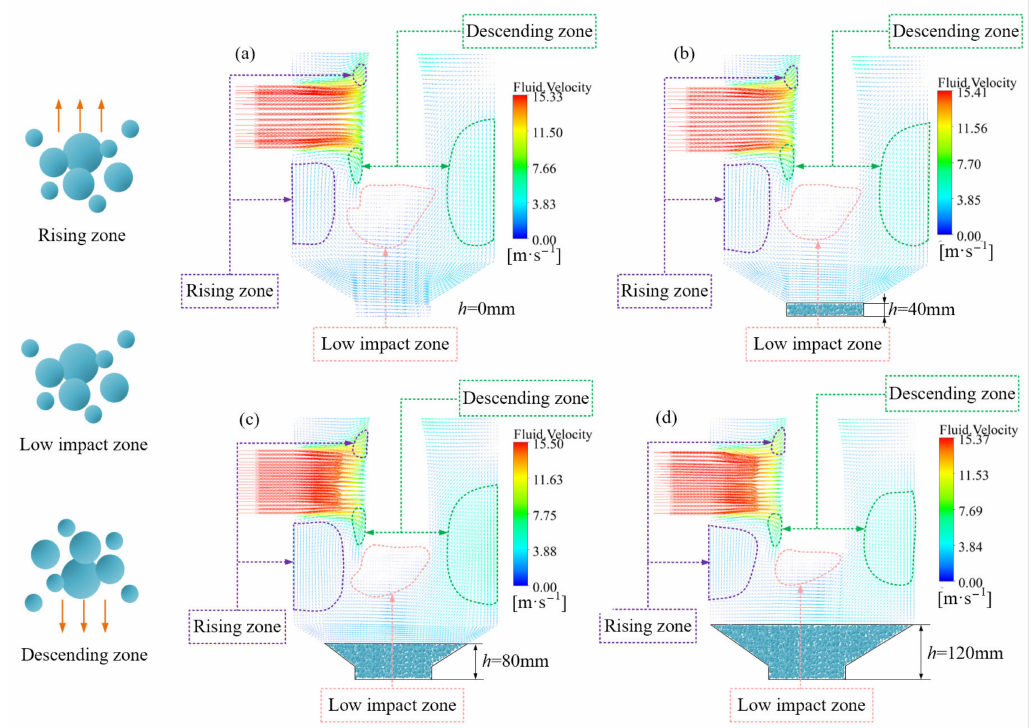
Figure 17. Velocity vector diagram of airflow region affecting particle motion: ( a ) h = 0 mm ( b ) h = 40 mm ( c ) h = 80 mm ( d ) h = 120